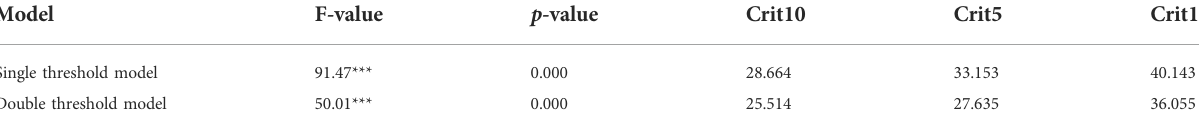
TABLE 9 Threshold test.